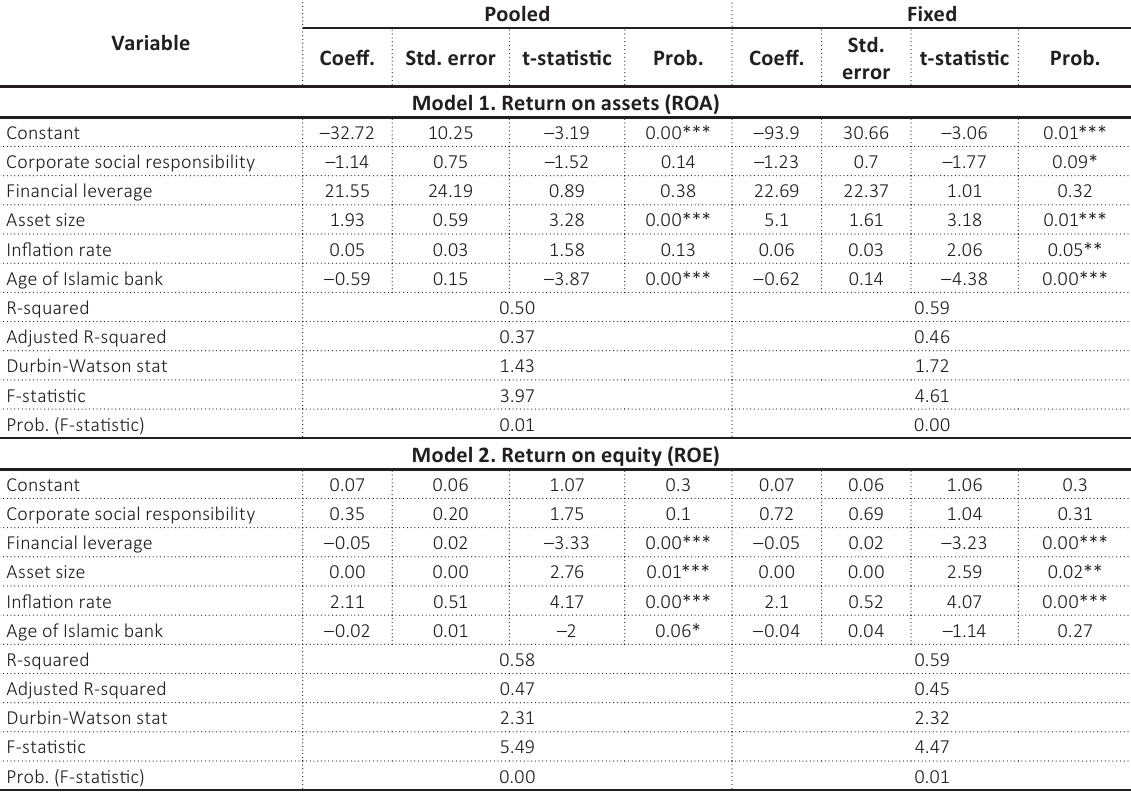
Table 5. ROA and ROE